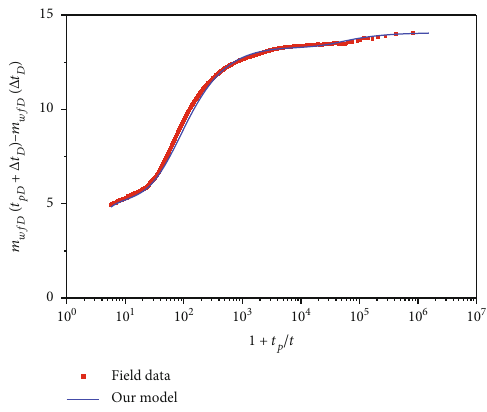
Figure 17: Dimensionless Horner match of the fi eld